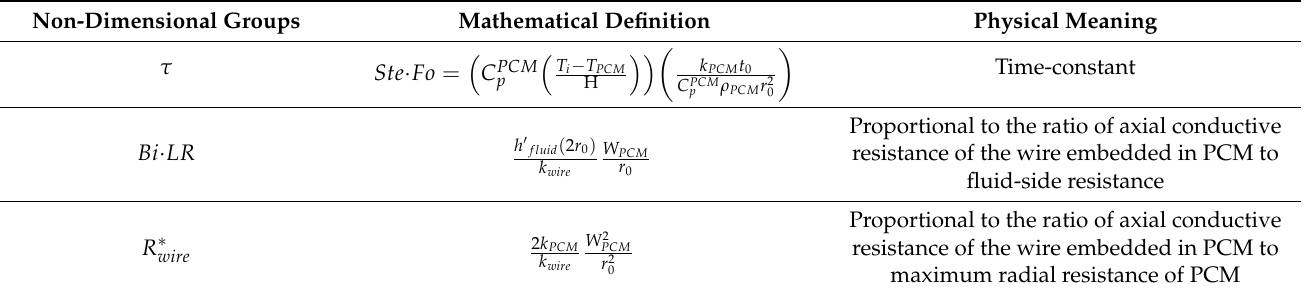
Table 1. List of non-dimensional